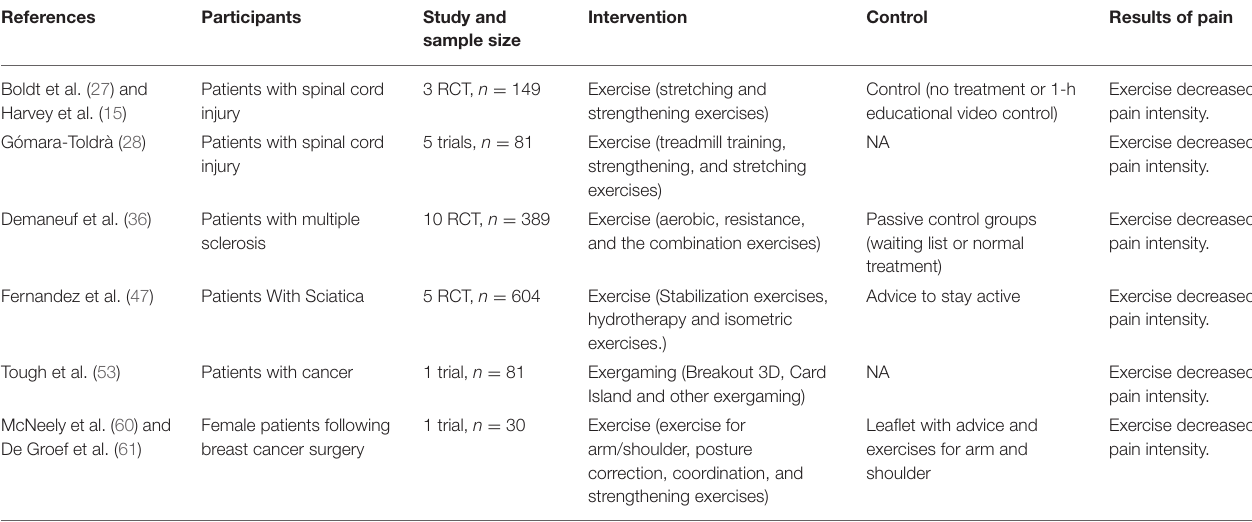
TABLE 4 | Characteristics of included systematic